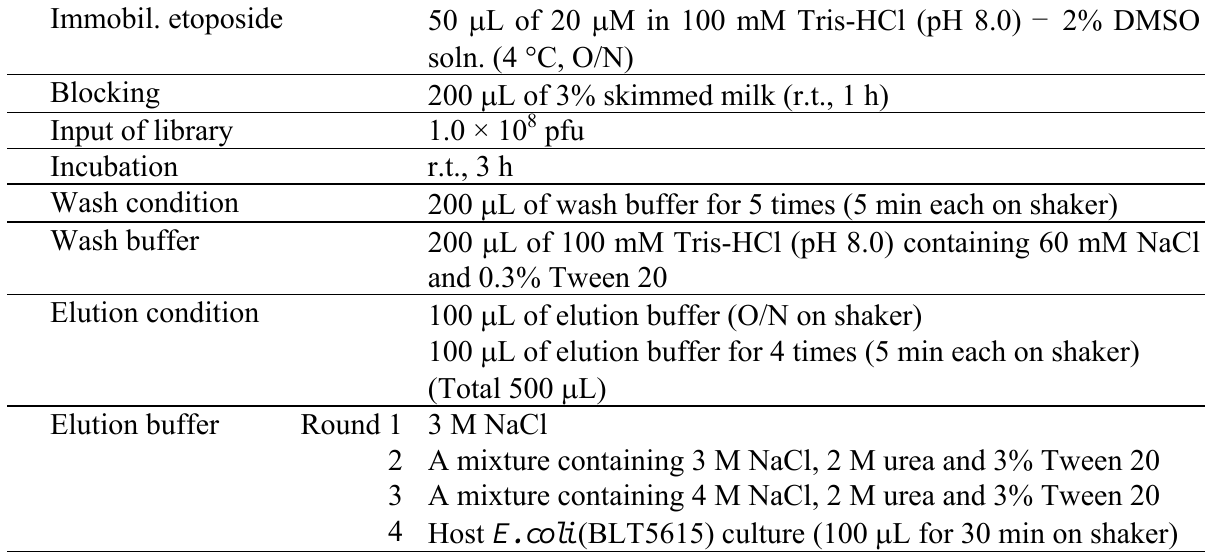
Table 1. Conditions for affinity selection using a biotinylated etoposide derivative and a streptavidin-coated 96-well